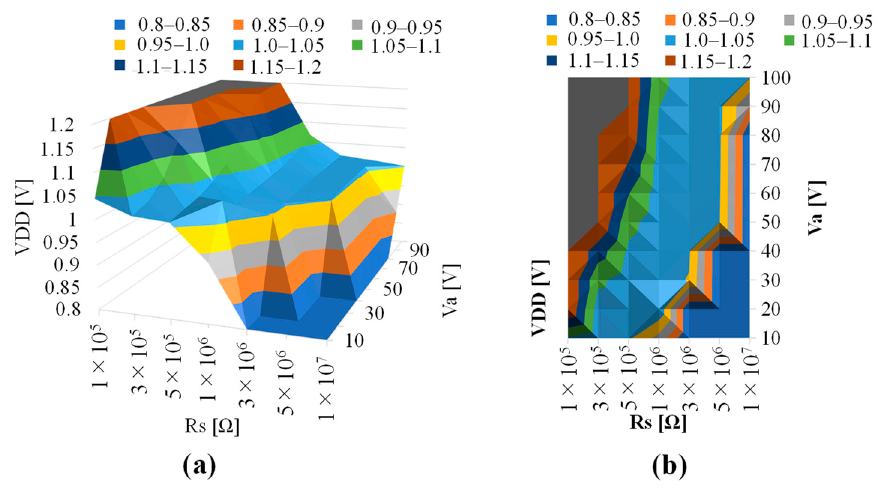
Figure 11. Simulated VDD with different V A and R S under a load resistance of 1 M Ω in ( a ) 3D and ( b ) top view plots.